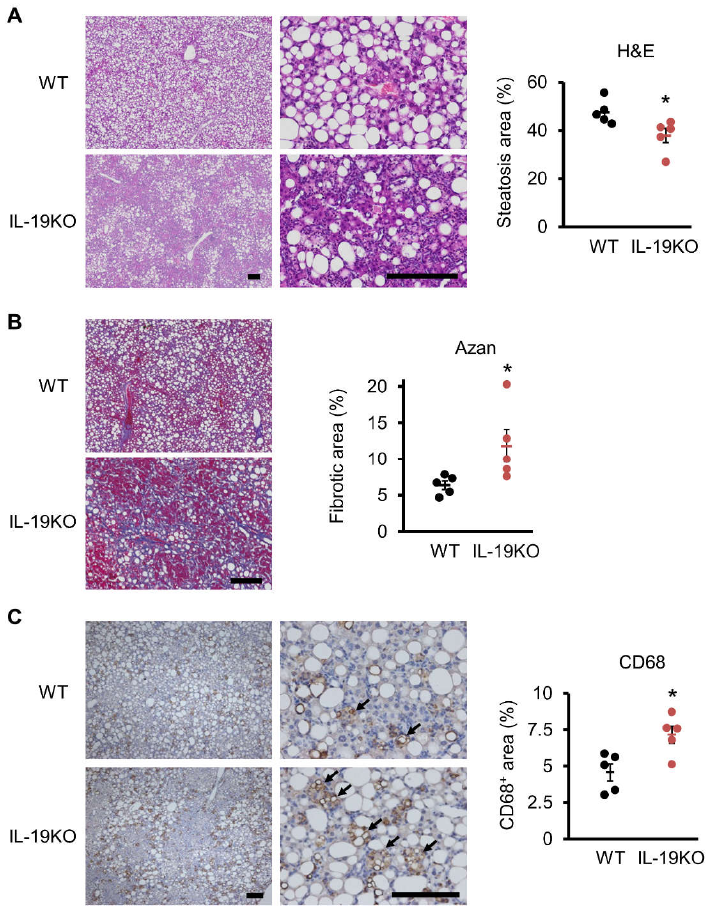
Figure 3. H&E, Azan, and CD68 staining. WT and IL-19 KO mice were fed a CDAHFD diet for 9 weeks. ( A ) Representative liver sections stained with H&E are shown. Low and high magnification are shown. Empty envelopes were quantified using ImageJ and evaluated as steatosis ( n = 5). ( B ) Representative liver sections stained with Azan staining are shown. The blue color was quantified using ImageJ and evaluated as fibrosis ( n = 5). ( C ) Representative liver sections immunohistochemically stained with CD68 are shown. Low and high magnification are shown. Positive cells were quantified using ImageJ ( n = 5). Scale bars represent 200 μm. * p < 0.05 vs. WT.